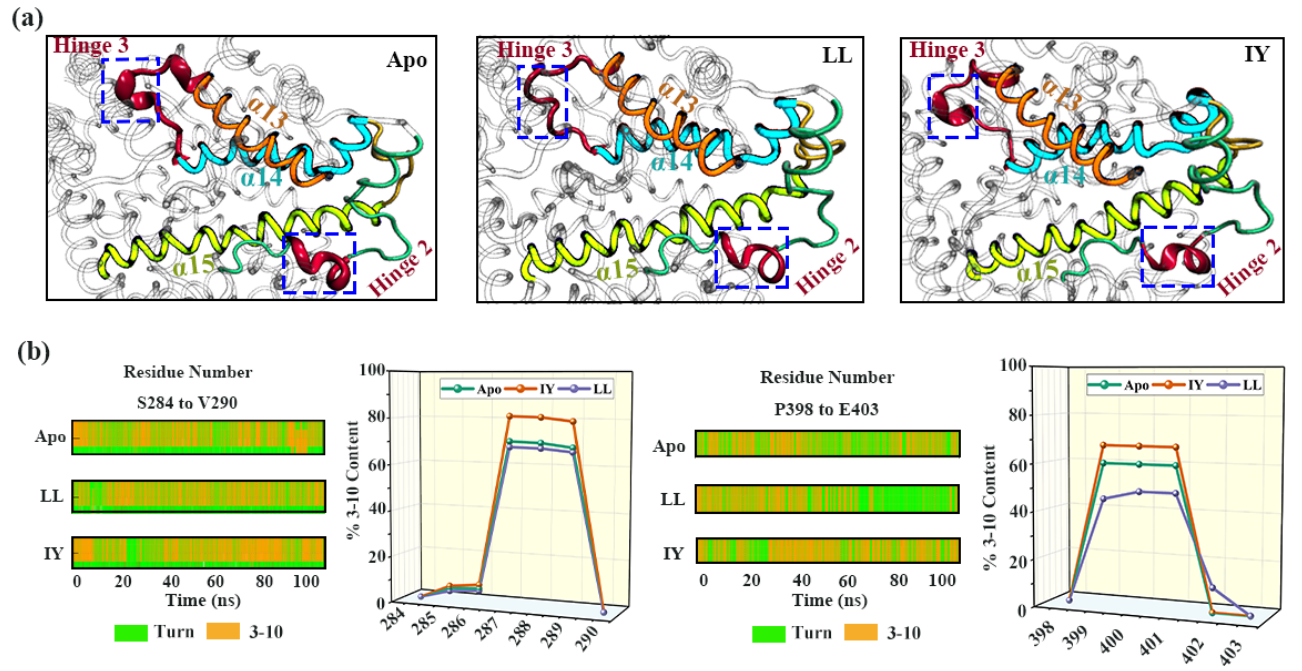
Figure 4. Analysis of the secondary structural changes of proteins: ( a ) representative snapshots of the three systems, and hinge 2 and hinge 3 are highlighted with rectangles; ( b ) DSSP (dictionary of secondary structure of protein) results for the three complexes and the helix probabilities of the corresponding residues. The Apo means ligand-free protein, LL represents the complex system of protein and dipeptide Leu-Leu, and IY stands for complex system of protein and dipeptide Ile-Tyr.